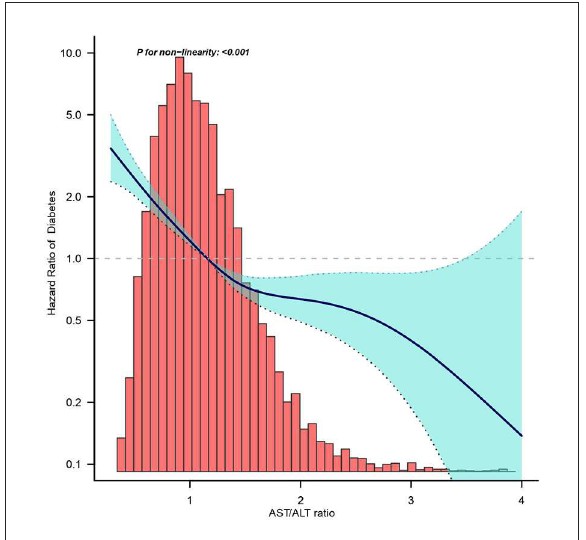
FIGURE2 Dose-response relationship between AST/ALT ratio and the incidence of diabetes in prediabetic